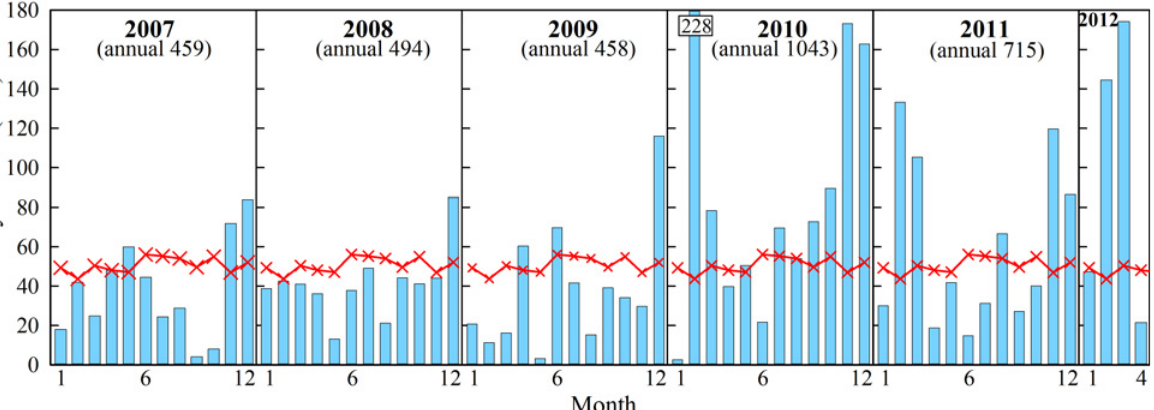
Fig 1. Measured monthly (blue shaded bars) and long-term mean (red crossed line) rainfall (mm) during the fallow and crop growth periods at the Harden field site.